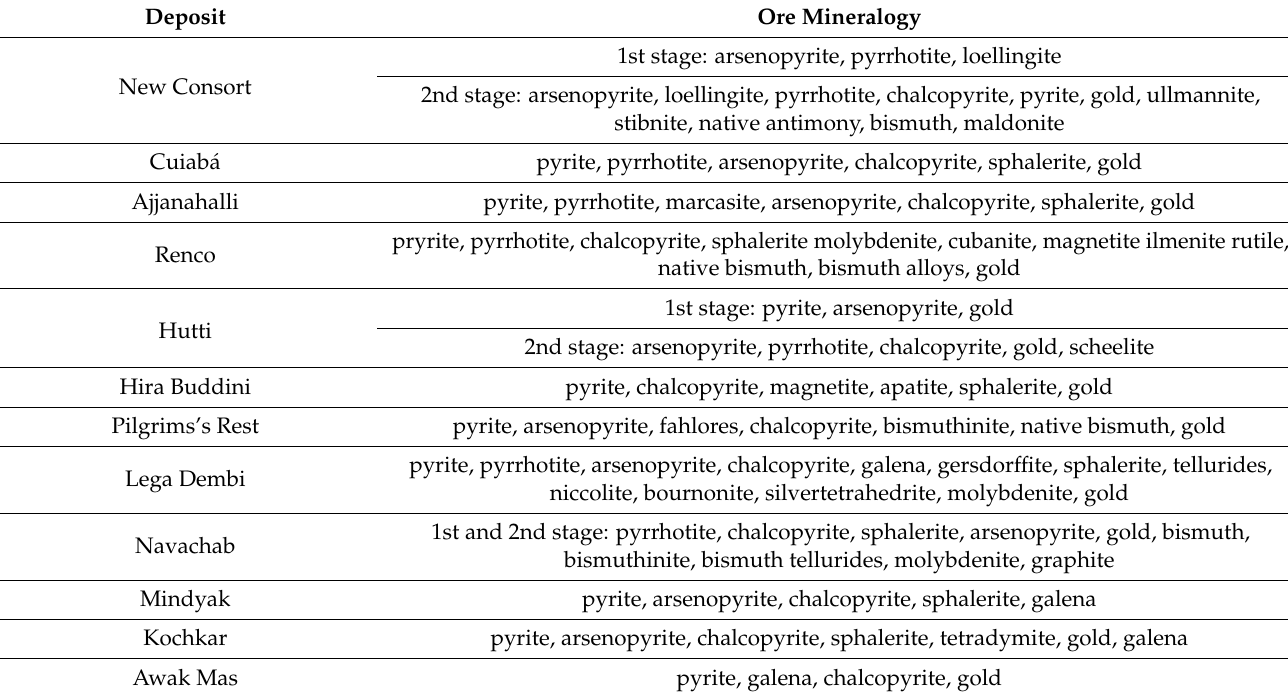
Table 6. Ore mineral